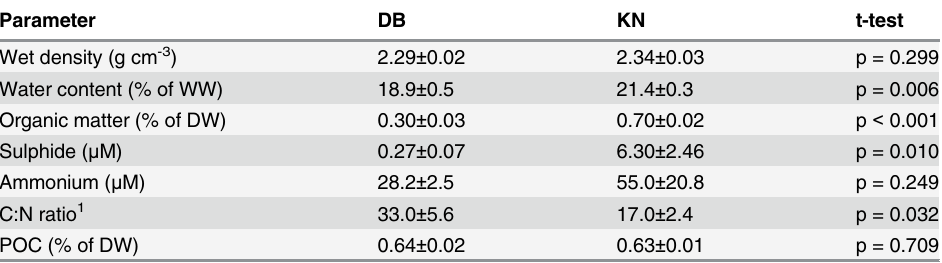
Table 2. Physical and biogeochemical sediment parameters (mean ± SEM) from DB and KN (n = 3 – 4).